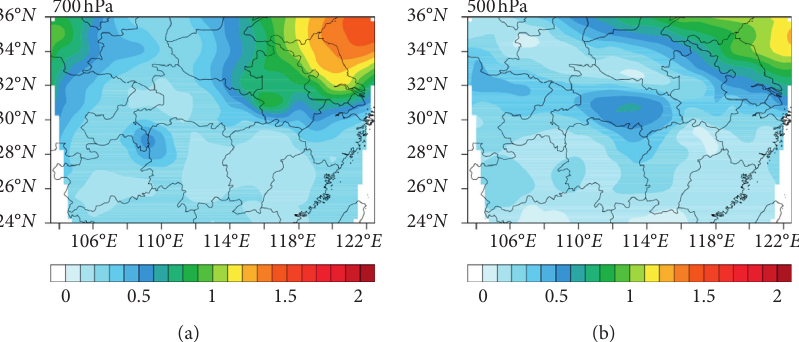
Figure 7: The spatial distribution of the standard deviation of the geopotential height (units:10 × gpm) at (a) 700 hPa and (b) 500hPa from 1 July to 2 July 2016.